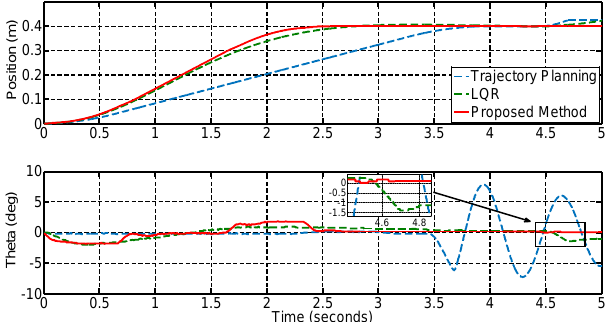
Figure 15. The response of three controls with disturbance.